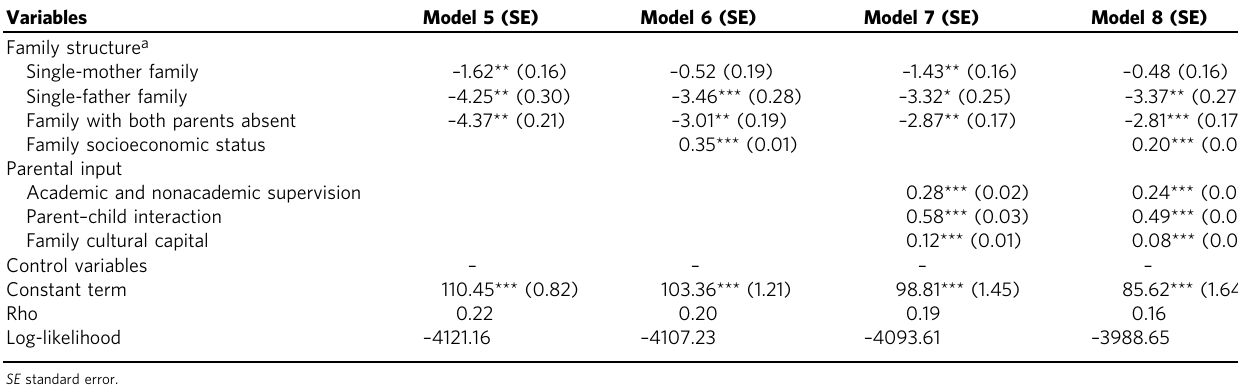
Table 3 Fixed-effect model for estimating academic achievement (AA) ( N =